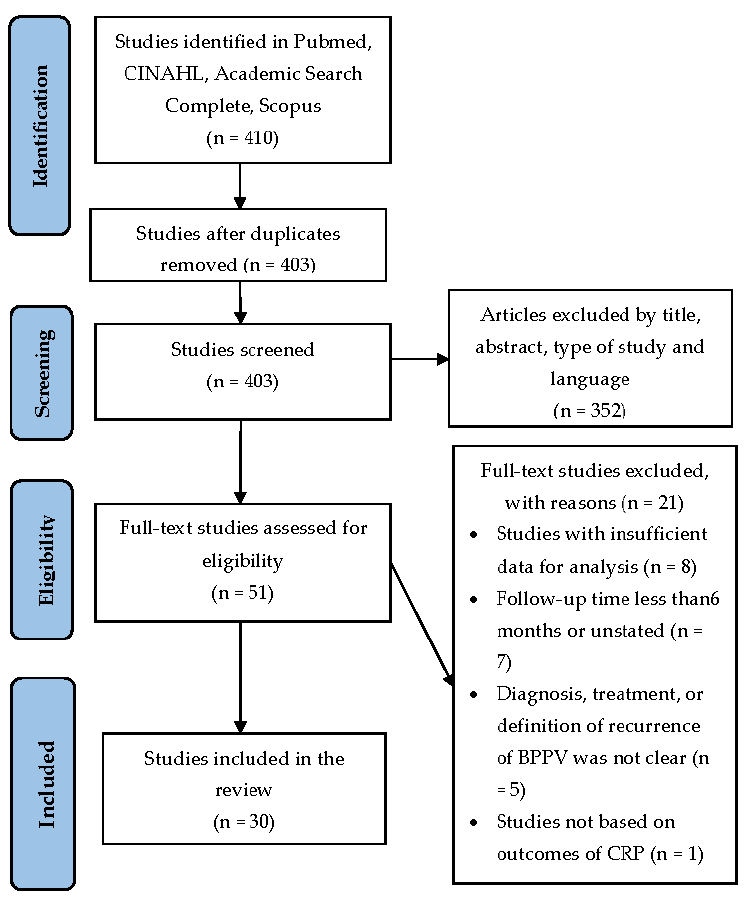
Figure 1 . Flowchart of data search and studies selection. Figure 1. Flowchart of data search and studies